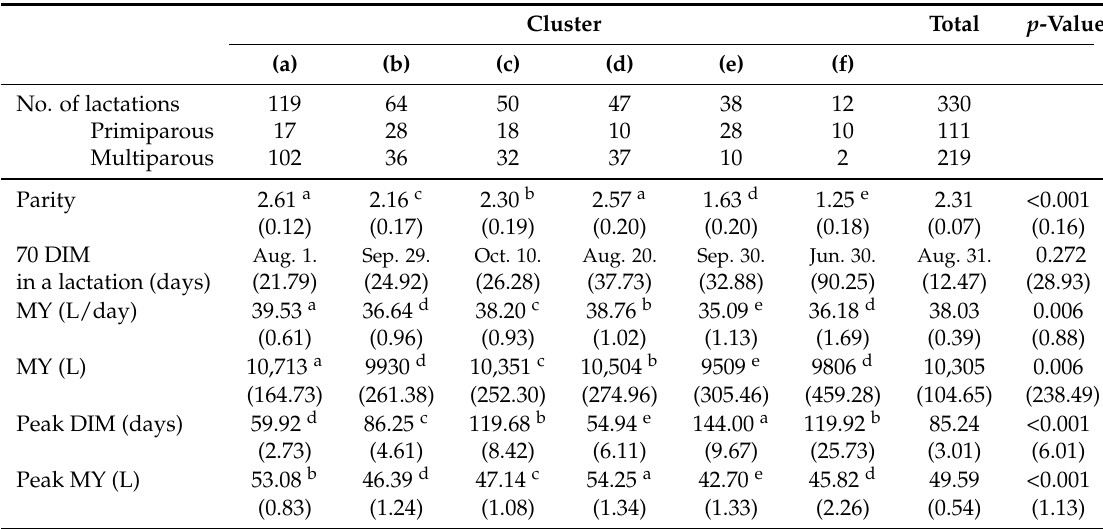
Table 4. Descriptive statistics of each cluster and the entire dataset.